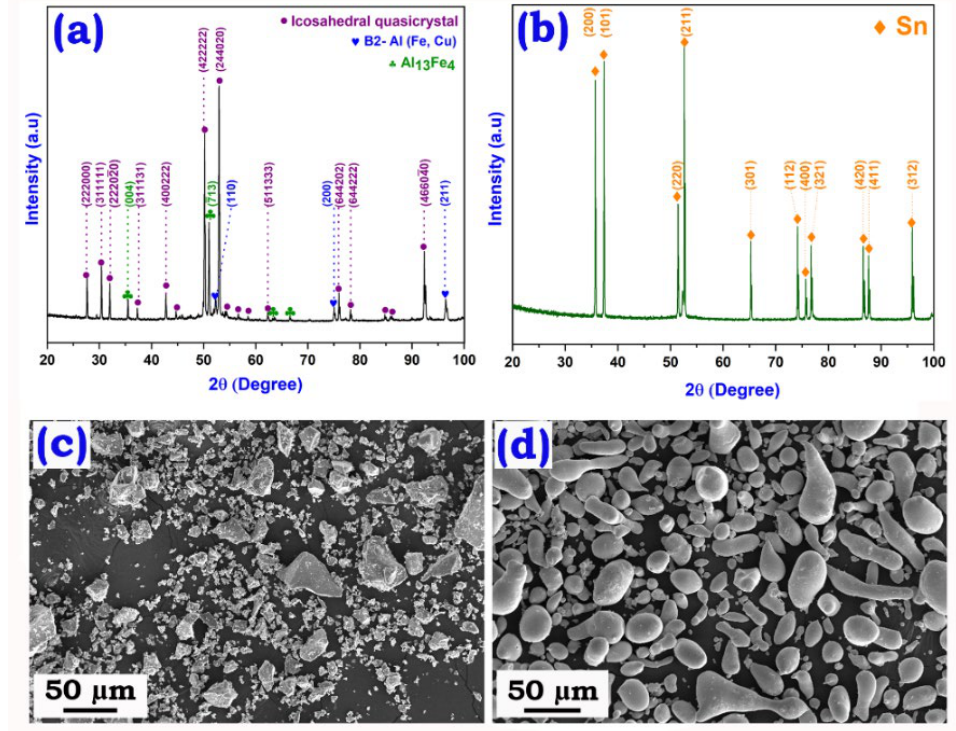
Figure 1. Phase analysis of ( a ) as-cast and annealed IQC alloys (IQC-AA) and ( b ) Sn reinforcement particles. SEM micrograph showing the morphology and size of ( c ) as-cast and annealed IQC alloys (IQC-AA) and ( d ) Sn particles.